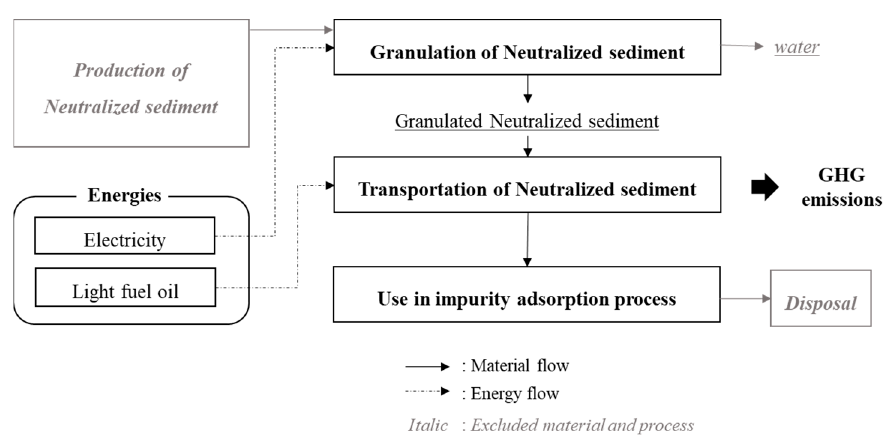
Figure 4. System boundary of granulated neutralized sediment production.